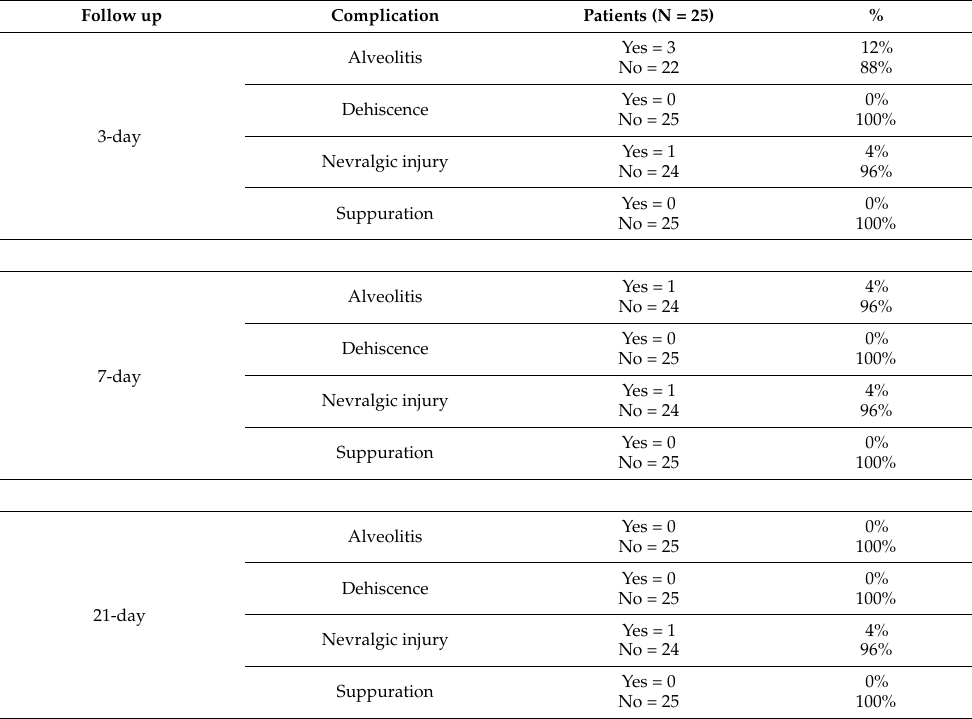
Table 7. Other post-operative